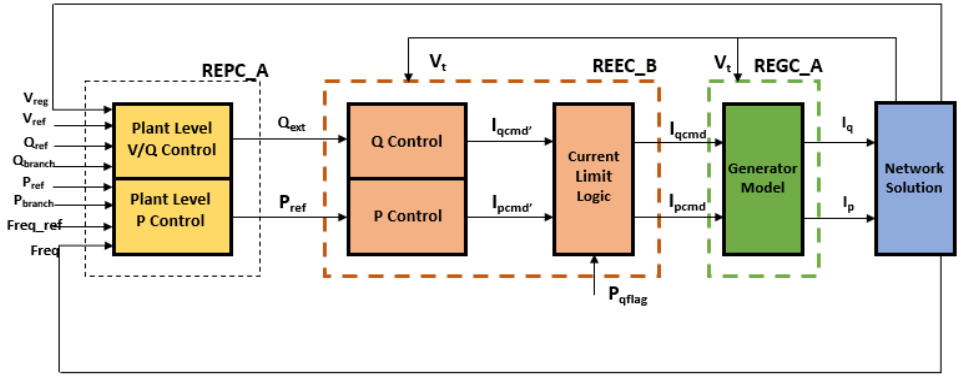
Figure 1. Block diagram for central station PV system model. Adapted from Ref. [24].